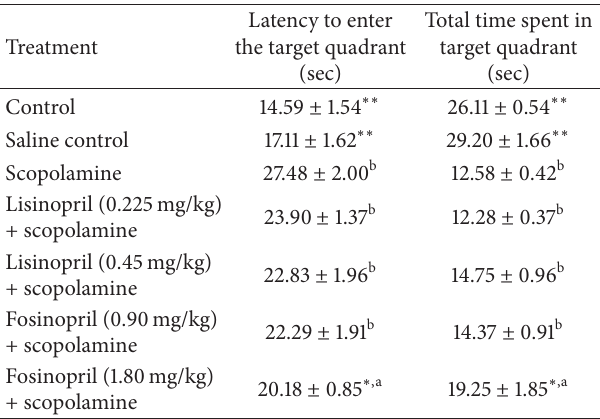
Table 5: Effects of lisinopril and fosinopril in the probe trial on day 5 of Morris water maze